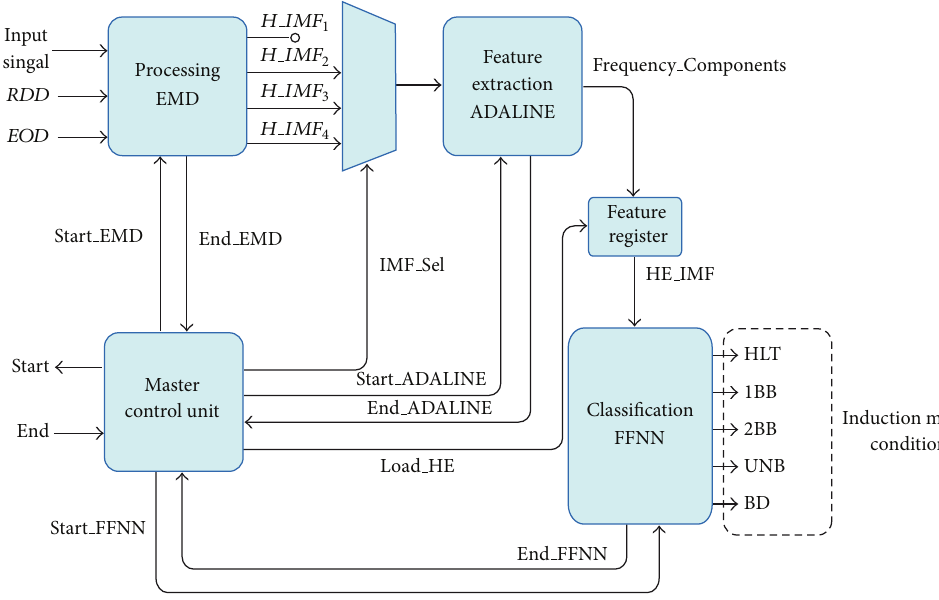
Figure 5: FPGA-based processor.